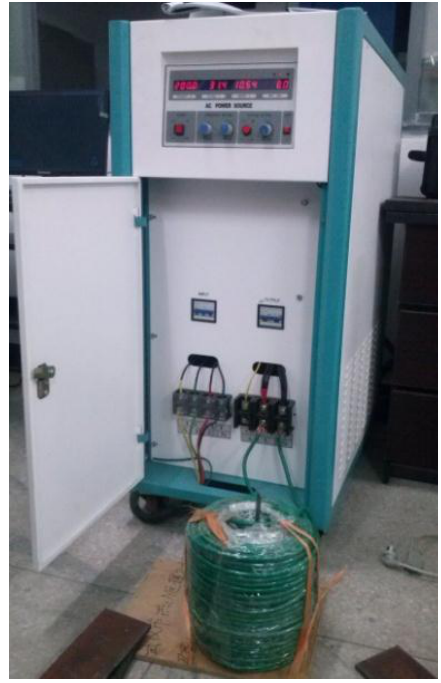
Figure 2. The setup of the magnetic treatment.